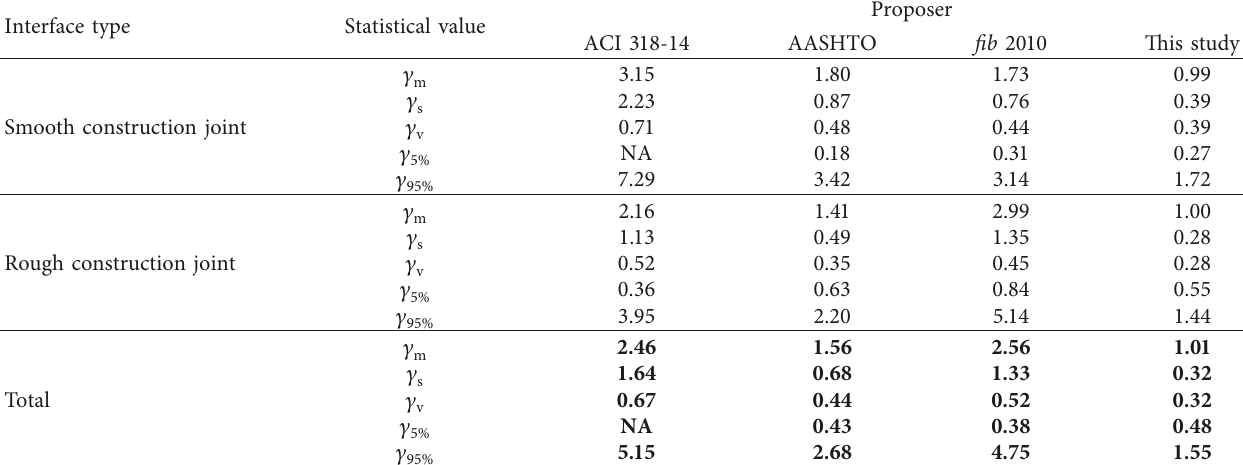
Figure 7: Comparisons of the measured and predicted shear friction strengths: (a) ACI 318-14 equation; (b) AASHTO equation; (c) fib 2010 equation; (d) this study. Table 2: Statistical comparison of measured and predicted shear friction